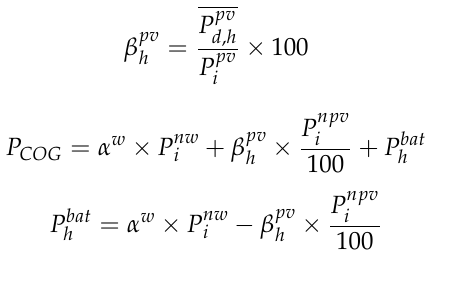
Figure 10. COG and RES in 2019–2022 ( a – d ). The bell power curve of the PV systems suggests that a coefficient of generation β pv be hourly calculated. It is the ratio between the average hourly available power generated by PV systems P pv and installed power P pv multiplied by i d , h